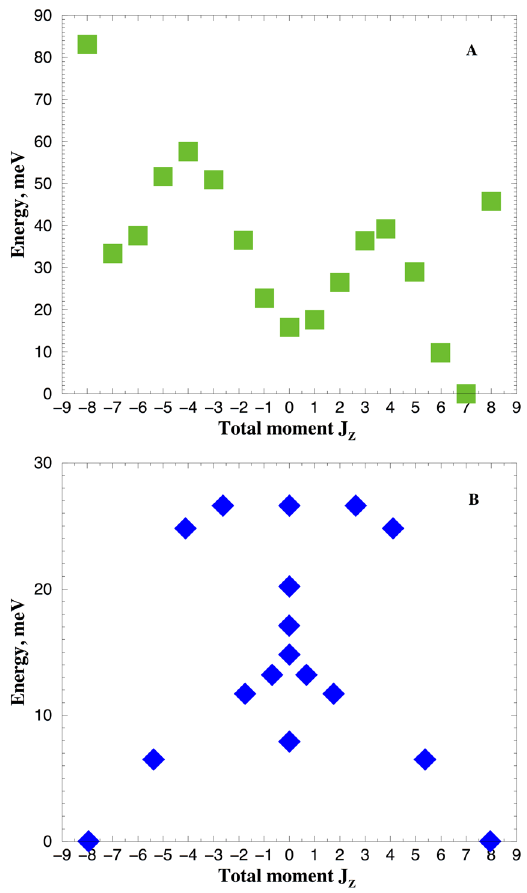
Δ = 10 meV ( A ); with the Δ ex CF parameters for non-spin-